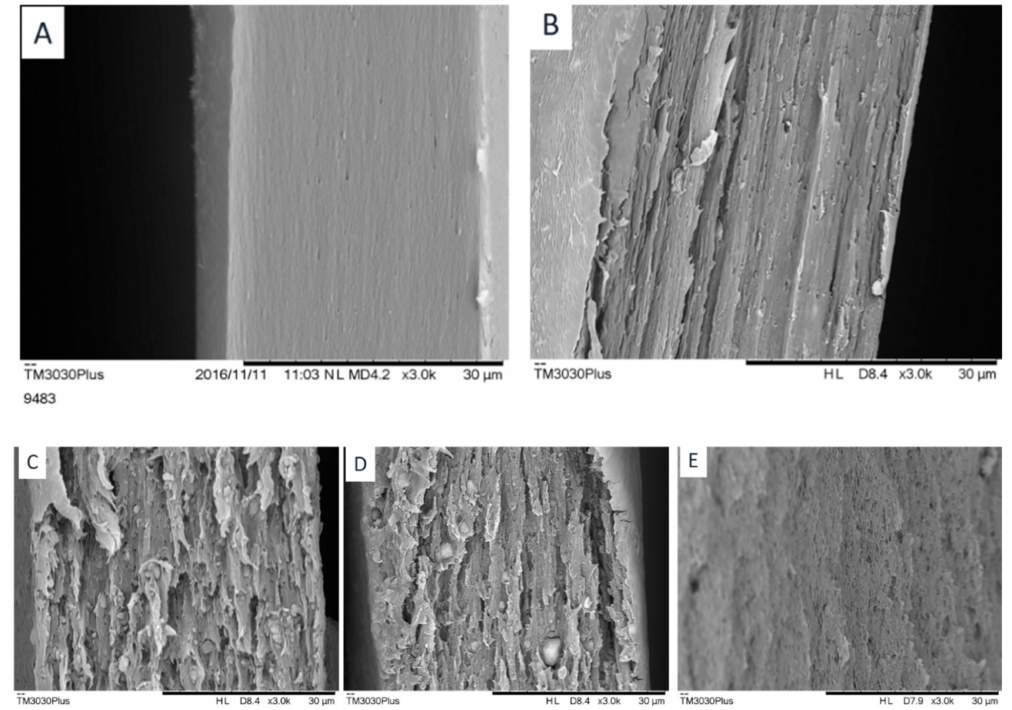
Figure 6. SEM images of membranes. ( A ) PTMSP, ( B ) PTMSP/30 wt % ZIF-7, ( C ) PTMSP/20 wt % ZIF-8, ( D ) PTMSP/20 wt % ZIF-L, and ( E ) PTMSP/20 wt % TiO 2